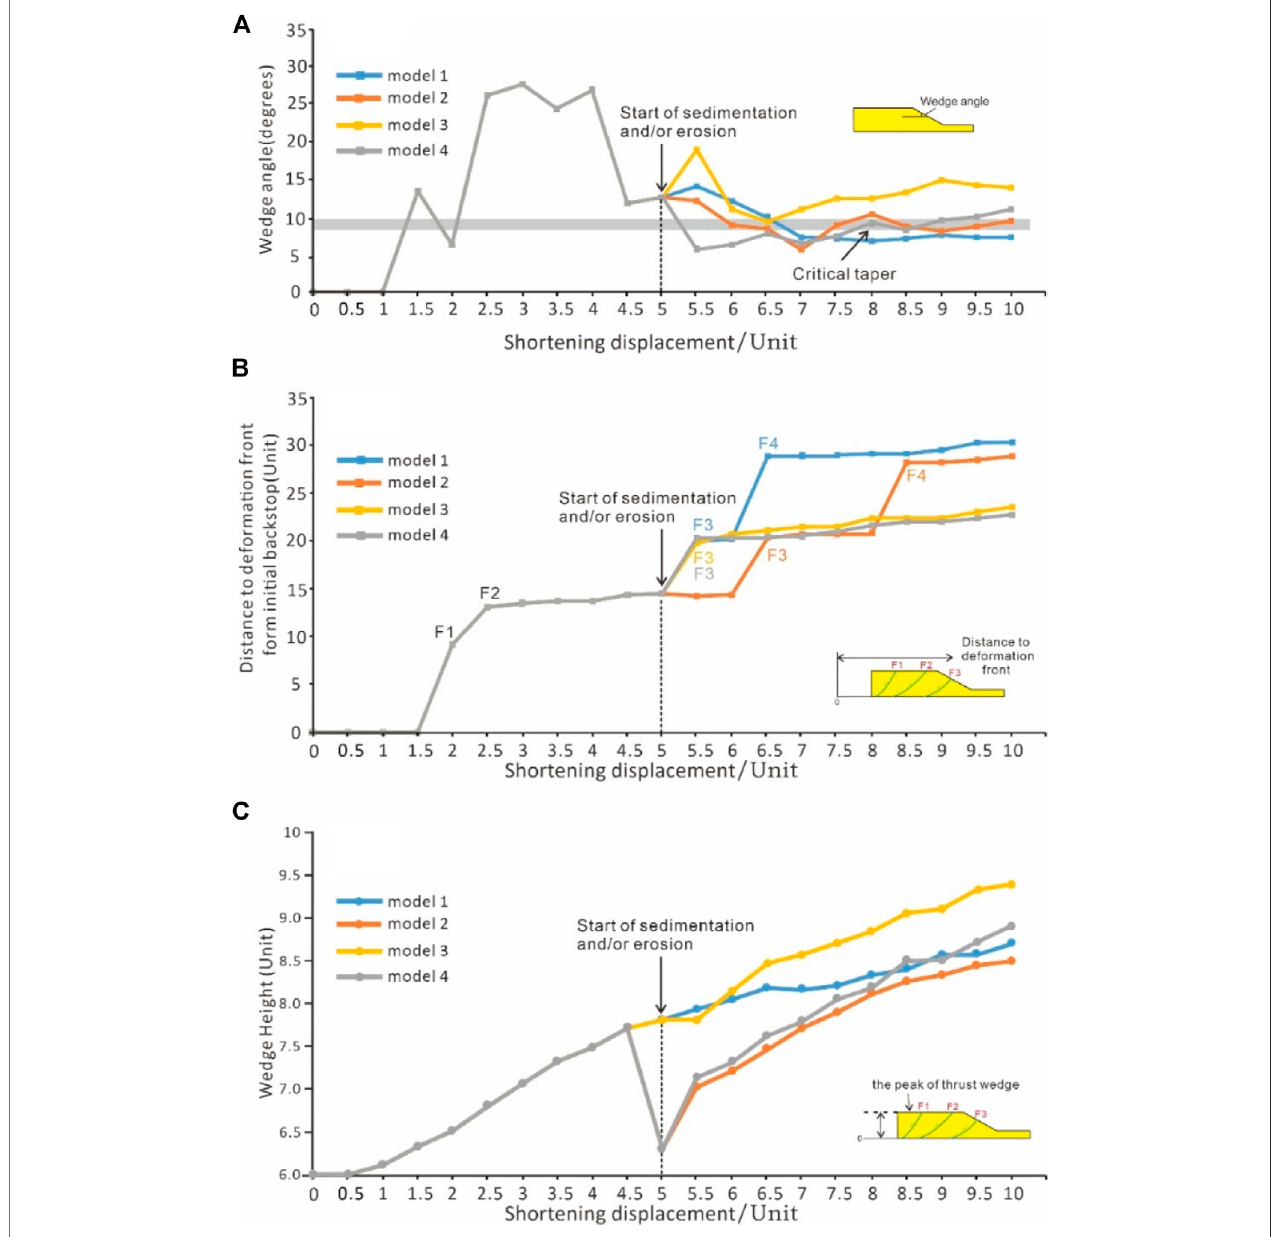
FIGURE8| Graphsshowingacomparisonof (A) thefrontwedgetaperanglevs.shorteningdisplacement, (B) thedistancetothedeformationfrontmeasuredfrom the initial backstop, and (C) the wedge height for models 1, 2, 3, and 4.